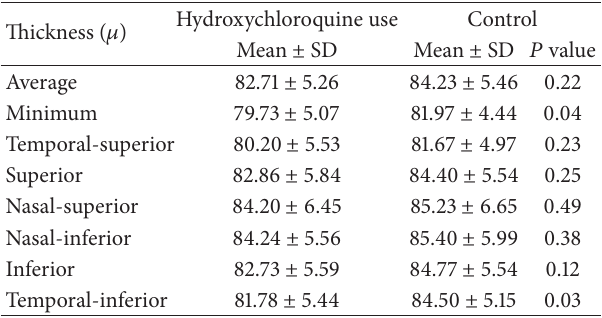
Table 3: Comparison of macular GCIPL thickness in hydroxy- chloroquine use and controls.